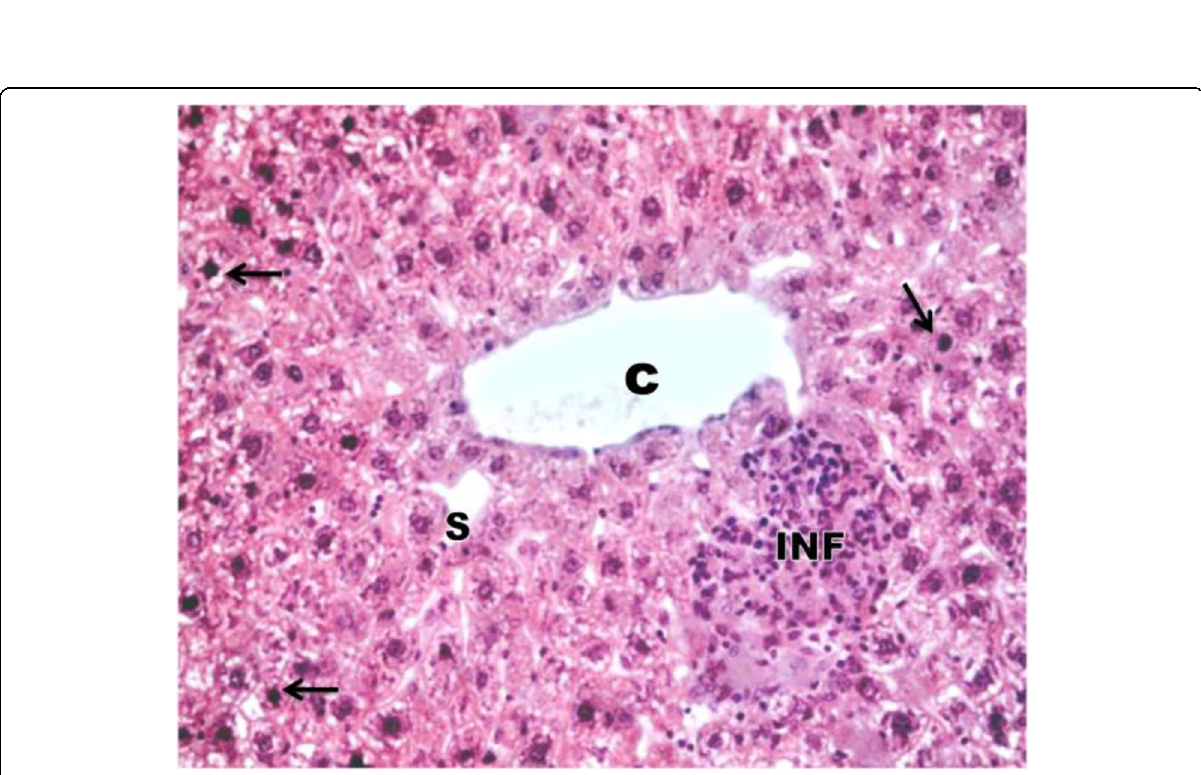
Fig. 11 Photomicrograph of a section of the liver of treated mouse with Tamiflu (16 mg/kg b.wt.) in addition to Adamine (20 mg/kg b.wt.) for 15 days showing hepatocytes with pyknotic nuclei (arrows), inflammatory cells (INF), enlargement of central vein (C), and damage of its endothelial lining and dilatation of hepatic sinusoid (S). (H&E, ×